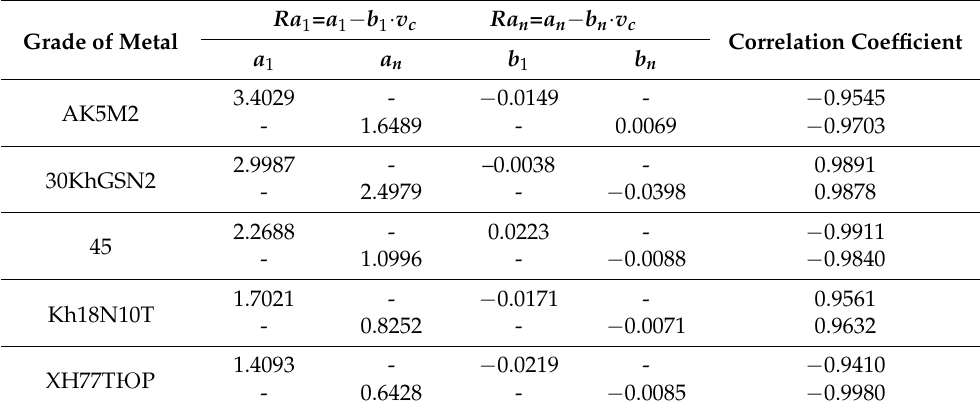
Table 5. Coefficients of the empirical function of the initial and final surface roughness depending on the cutting